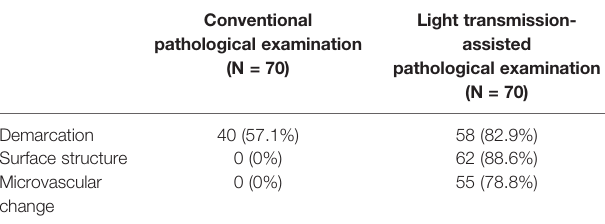
TABLE 2 | Differences between the conventional and light transmission-assisted pathological examinations.